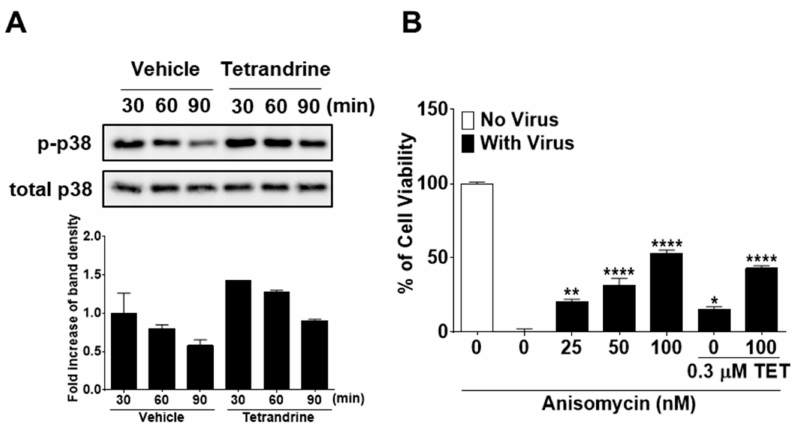
Figure 8. Increased phosphorylation of p38 mitogen-activated protein kinase (MAPK) by TET treatment in HCoV-infected MRC-5 cells with no antiviral synergistic e ff ect of TET and anisomycin. ( A ) Cells were infected with HCoV-OC43, and 5 µ M TET (vehicle 0.025% DMSO) was added to the cell cultures. Cell lysates were harvested at 30, 60, and 90 min post-infection. Western blot analysis was performed to determine the extent of p38 phosphorylation (Thr180 / Tyr182). Total p38 was used as a